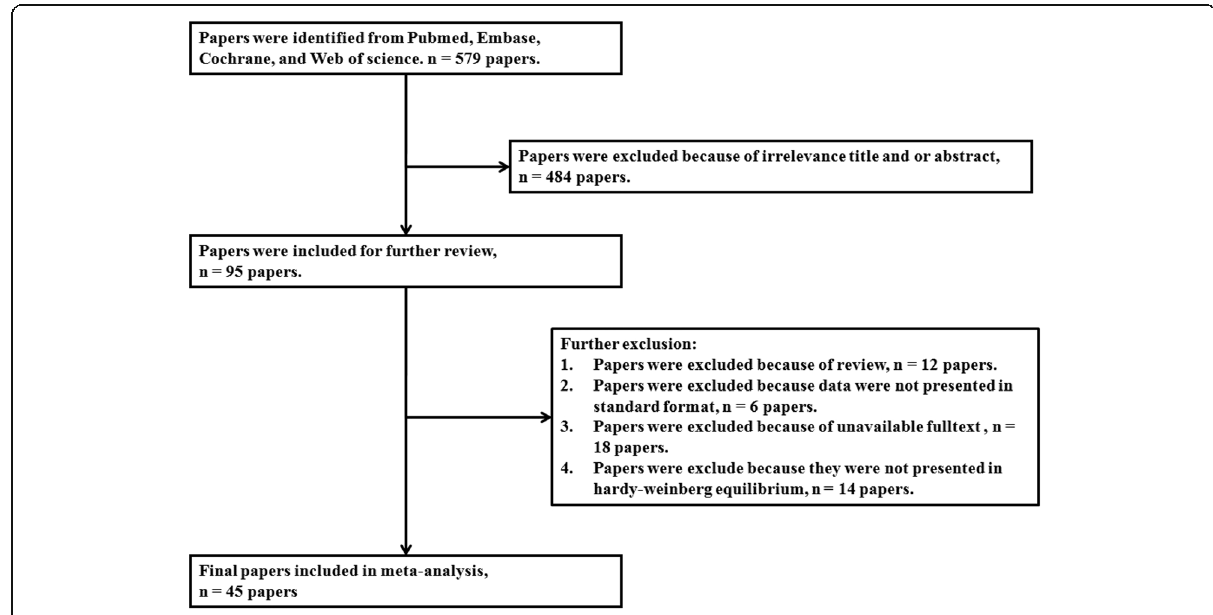
Fig. 1 Flowchart of eligibility pathway in our